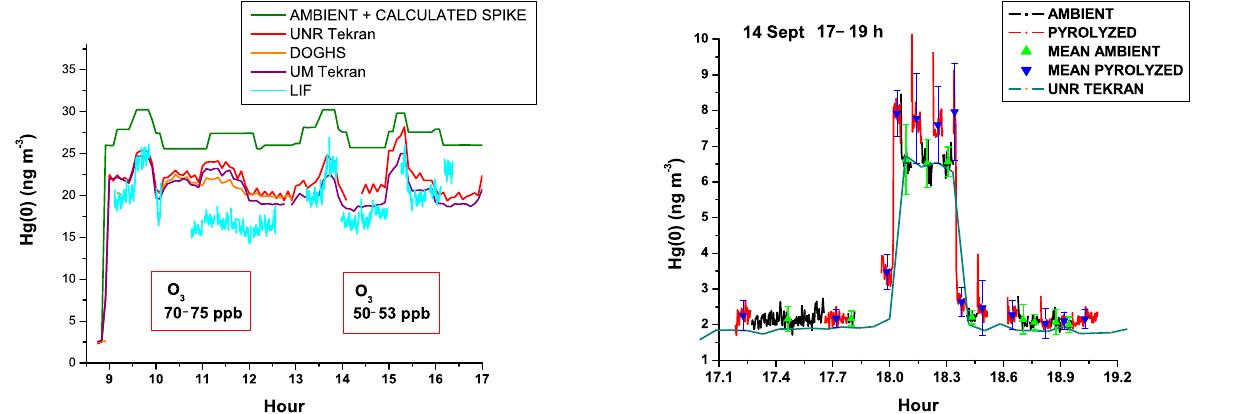
Figure 7. Measurements from 14 September, hours 17–19 (17:00– 19:00PDT). The background-subtracted 2P-LIF signals from the ambient (black) and pyrolyzed (red) sampling lines are shown. The gaps correspond to times when the laser was blocked to check power and background. The means and 1 standard deviation of each sam- ple are shown. The absolute Hg(0) concentrations are obtained by scaling the ambient Hg(0) signal to the absolute Hg(0) concentra- tion reported by the UNR Tekran during the Hg(0) manifold